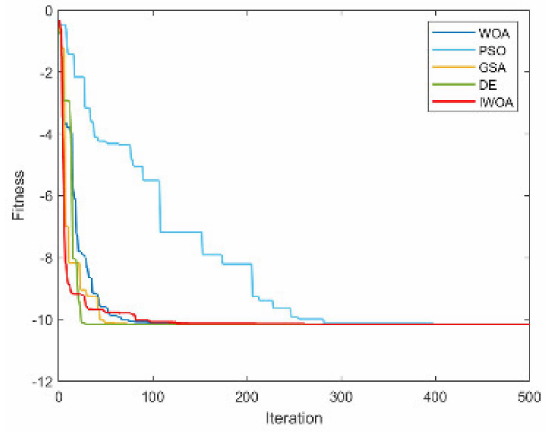
Figure A14. The convergence curve for solving